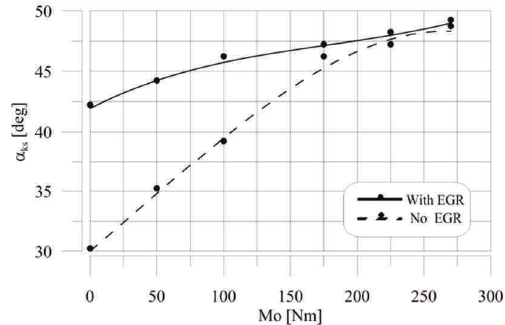
Fig. 22. Influence of the engine load on the end of combustion a ks for engine operating with/without